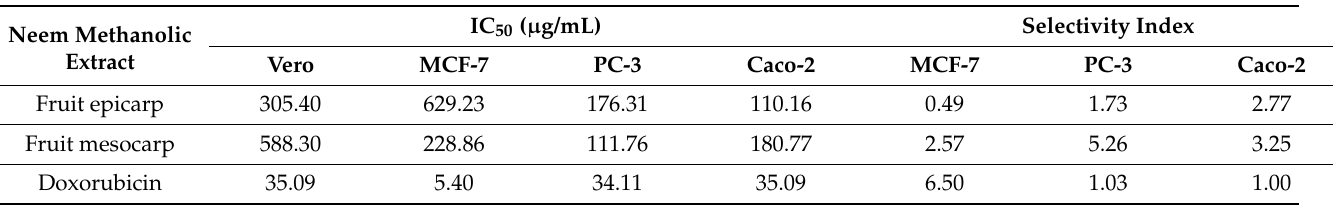
Figure 5. Morphology of MCF-7, PC-3, Caco-2, and Vero cells after 48 h from the treatment with different concentrations of the methanolic extract of neem fruit mesocarp. Table 6. IC 50 ( µ g/mL) and selectivity index of the methanolic extracts of neem fruit epicarp and mesocarp against different cell